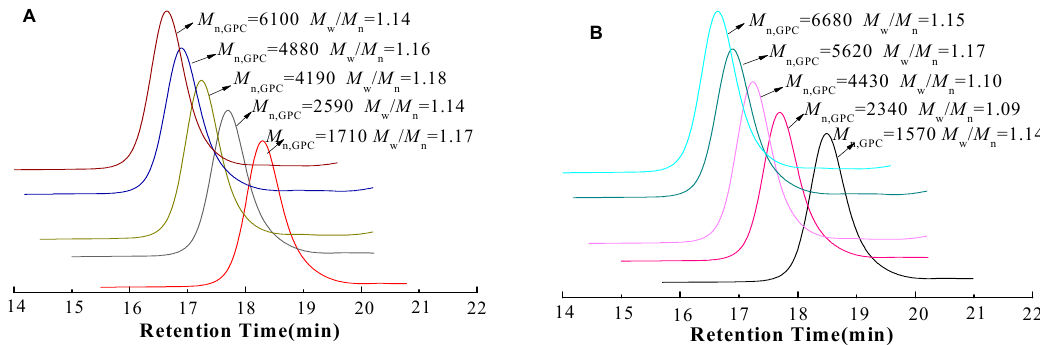
Figure 1. GPC traces of ( A ) GA-PNIPAM (i); ( B )GA-PNIPAM (ii) obtained through ATRP.